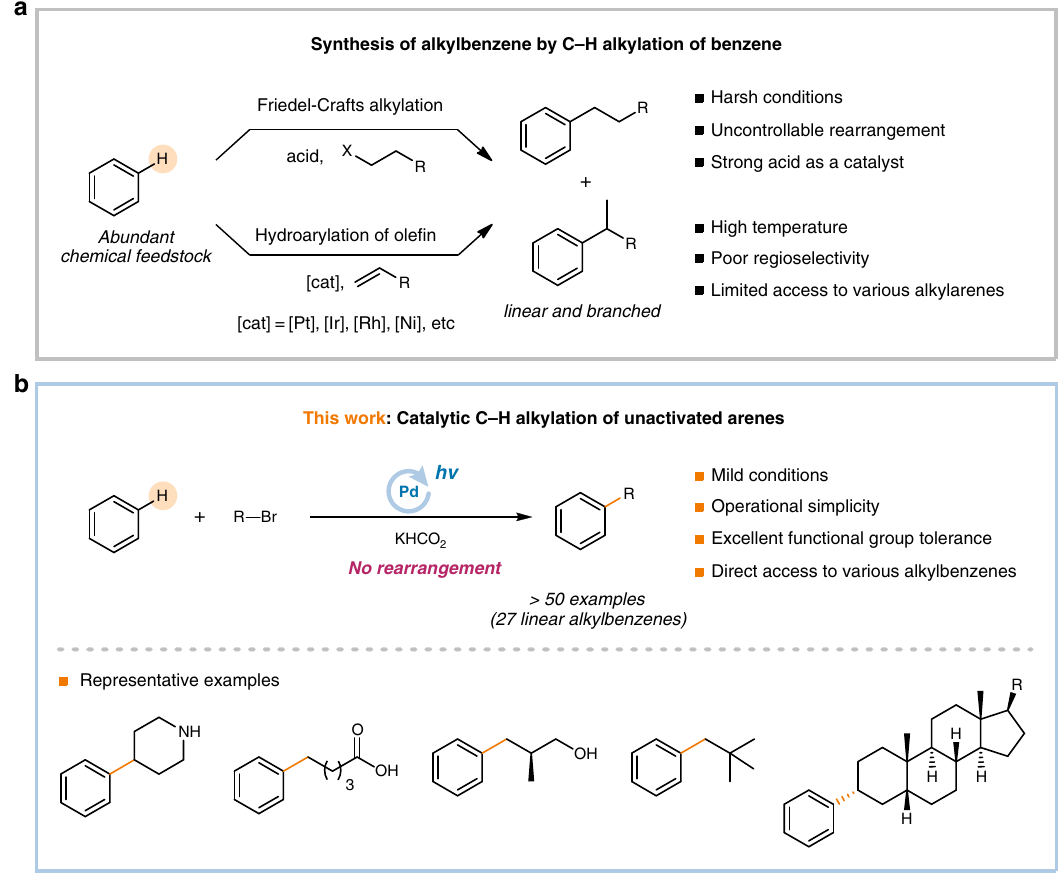
Fig. 1 Synthesis of alkylbenzenes. a Synthesis of alkylbenzene by C – H alkylation of benzene. b Catalytic C – H alkylation of unactivated